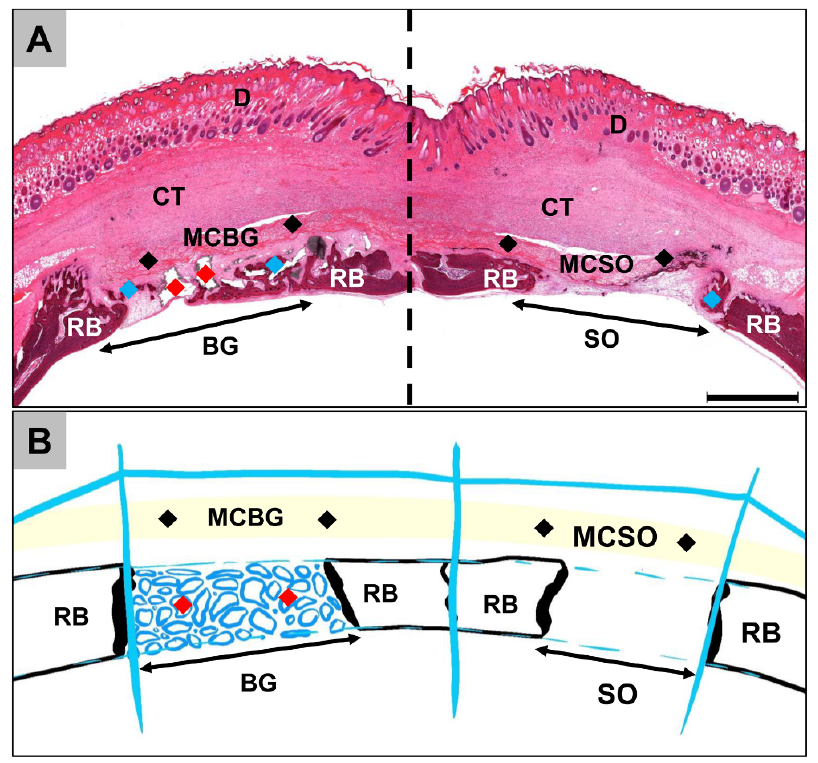
Figure 7. ( A , B ) Schematic overview of a calvaria, involving the four different compartments used for histomorphometrical measurement. BG and double-arrow = bone graft-filled bone defect; SO and double-arrow = sham-operated bone defect; MCBG = membrane compartment above bone graft- filled bone defect; MCSO = membrane compartment above sham defects; blue rhombus = newly formed bone tissue; red rhombus = bone substitute material; black rhombus = collagen membrane; RB = residual bone; CT = connective tissue; D = dermis. ( A ) HE staining, “total scan”, 100 × magnifi- cation, scale bar = 5